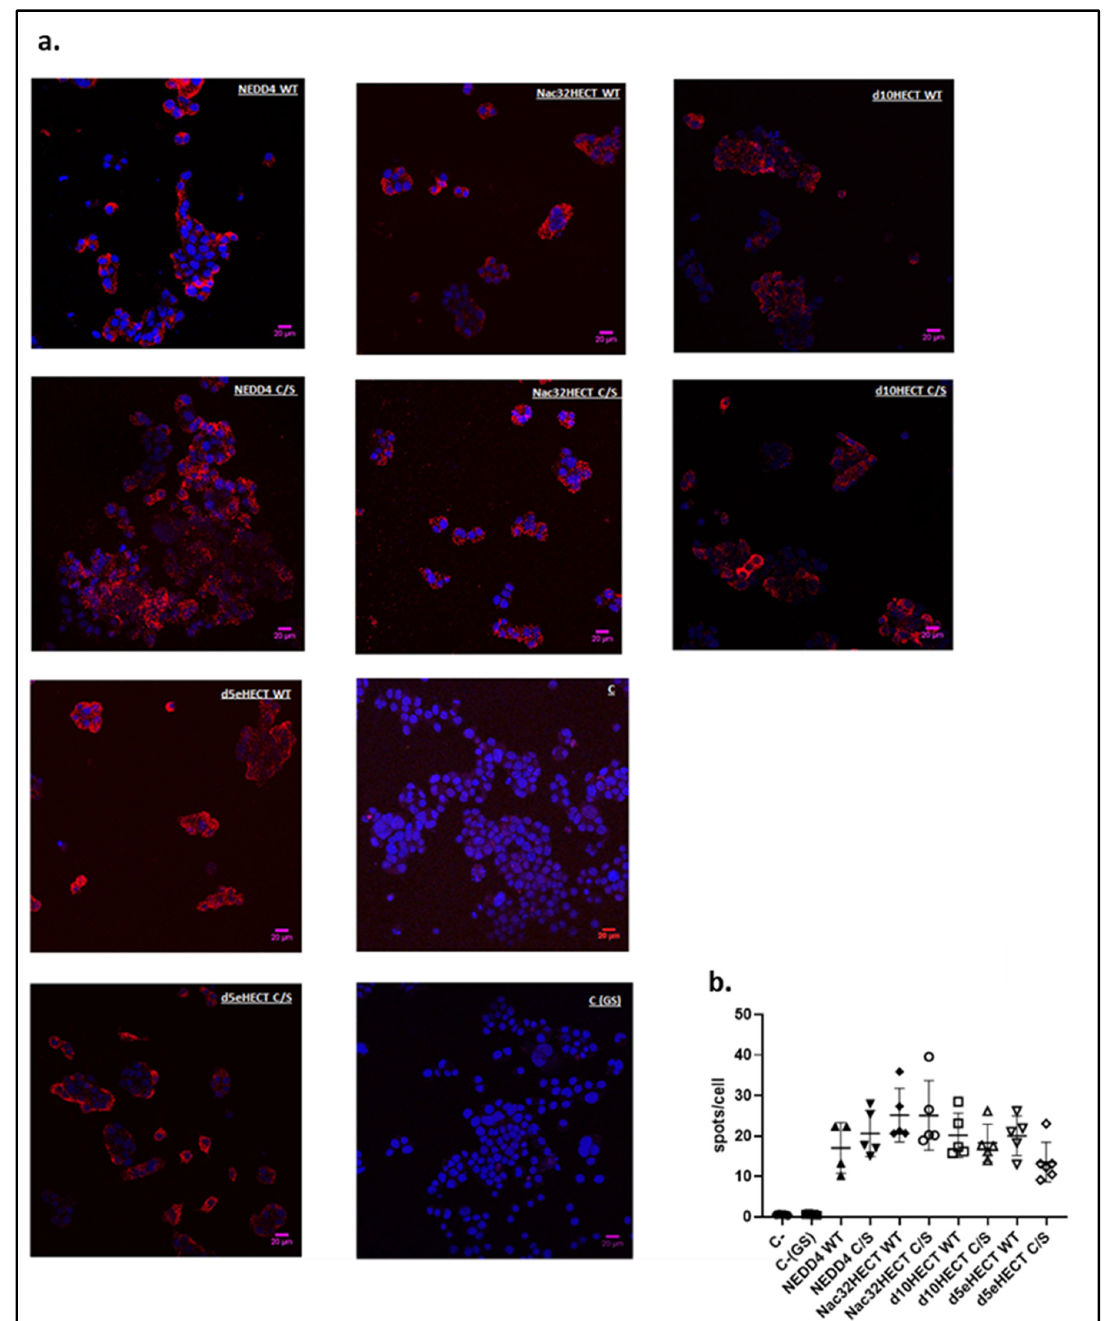
Figure 4. Ubiquibodies specifically interact with aS in murine dopaminergic cells. ( a ) MN9Dsyn cells (4 × 10 4 ) were transduced with RLPs expressing similar amount of ubiquibodies and 24 h later, aS expression was induced by treatment with DOX (1 µ g/mL). The following day, cells were fixed with 4% v / v PFA and stained with an anti-HA and an anti-aS antibody, followed by PLA probes minus and plus ligation and amplification. Two negative controls were adopted: (i) cells were incubated with the aS antibody alone (panel C, third line, right panel); (ii) cells were incubated with aS and GS antibodies (C (GS), last line, right panel). Cells were analyzed by confocal microscope. In blue—(DAPI): nuclei; in red—PLA spots. Name of ubiquibodies expressed in the different samples are reported. Shown scale bar corresponds to 20 µ m. ( b ) One-way ANOVA (GraphPad Prism version 8.0.0 for Windows, GraphPad Software, Inc, San Diego, CA, USA) statistical analysis was performed by adopting 6 images per each sample. Results are expressed as mean ± SD taken in 6 different regions of the cell culture, from two separate experiments. All the ubiquibody samples have p < 0.0001 with respect to the negative control